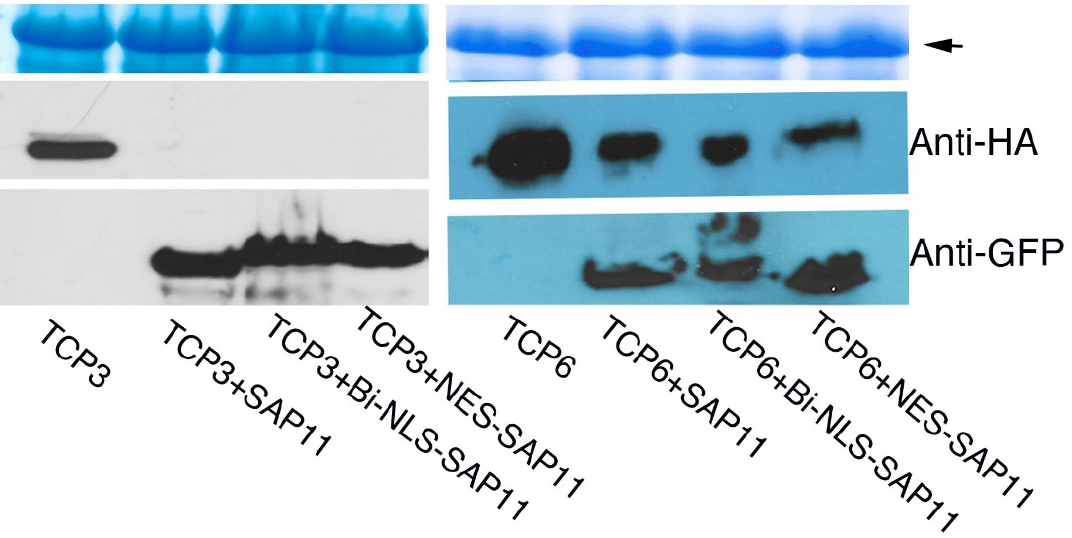
Figure 3. Western blot analysis of the destabilizing activity of SAP11 PM19 in cytoplasm and nucleus. AtTCP3-HA (TCP3) and AtTCP6-HA (TCP6) were co-transiently expressed with SAP11 PM19 -GFP (SAP11), NES (NES-SAP11) or bi-NLS-SAP11 PM19 -GFP (Bi-NLS-SAP11) in N. benthamiana plants. The expressed proteins were extracted and subjected to an SDS-PAGE and Western blot analysis using anti-GFP for detecting SAP11 PM19 expression (lower panel) and anti-HA-POD for detecting AtTCP3- HA and AtTCP6-HA (middle panel) expression. The Coomassie blue staining of a large subunit of Rubisco (arrow, upper panel) was used for controlling the total loading proteins.